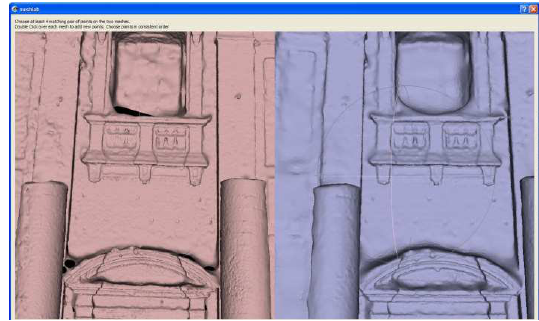
Figure 14: San Nicola 136 dataset – on the left High Resolution photos 3D model, on the right Low Resolution photos 3D